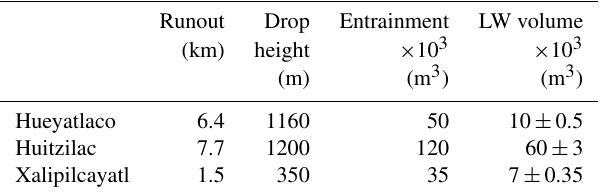
Table 2. Main morphometric data of the debris flows that were ob- served in the Hueyatlaco, Huitzilac, and Xalipilcayatl basins. The entrained volume was calculated assuming 0.5m of erosion over the area located downstream from the main scars where the vege- tation was destroyed. The volume of large wood (LW) recruitment was calculated considering a mean tree height of 25m (with an un- certainty of ± 5m), a mean trunk diameter of 0.4m (with an uncer- tainty of ± 0.1m), and a mean distance of two trees of 10m based on field observations and inspection of post-event optical images. Runout Drop Entrainment LW volume (km) height × 10